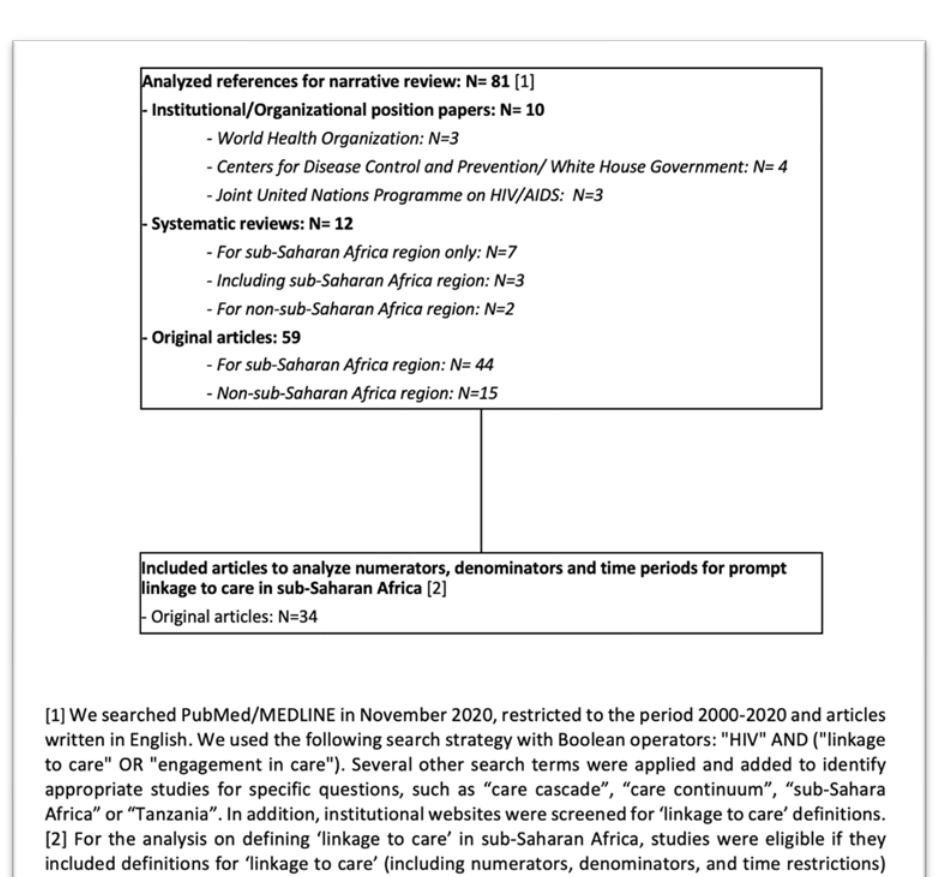
Figure S1: Search results for the narrative